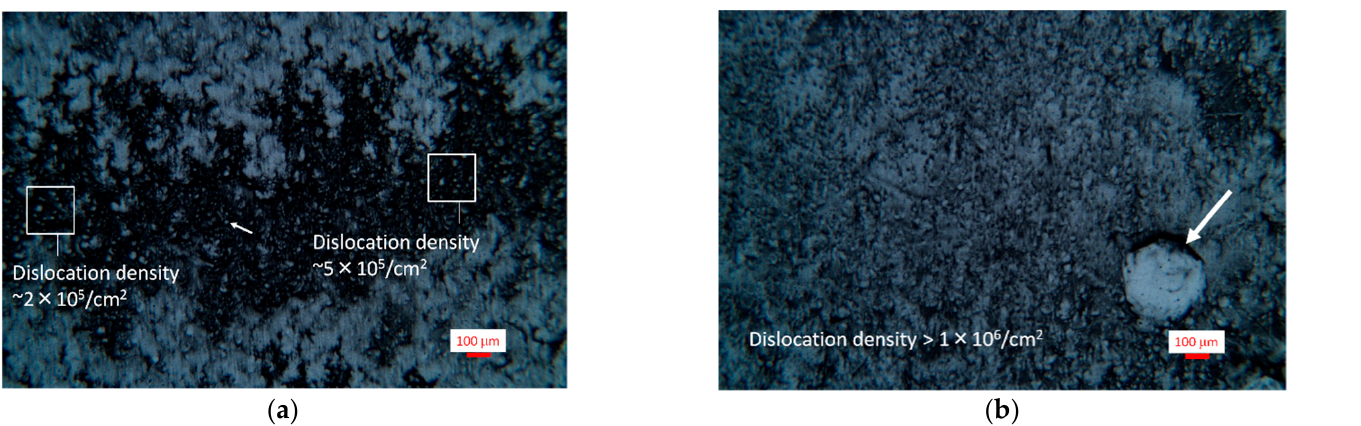
Figure 8. X-ray topography from the 100 mm-bulk GaN crystal. ( a ) From as-grown N-polar surface; ( b ) from Ga-polar surface which exposes Ga-face of the HVPE seed. ( b ) from Ga-polar surface which exposes Ga-face of the HVPE